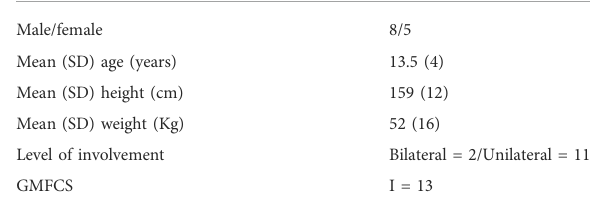
TABLE 1 Participant characteristics ( n =